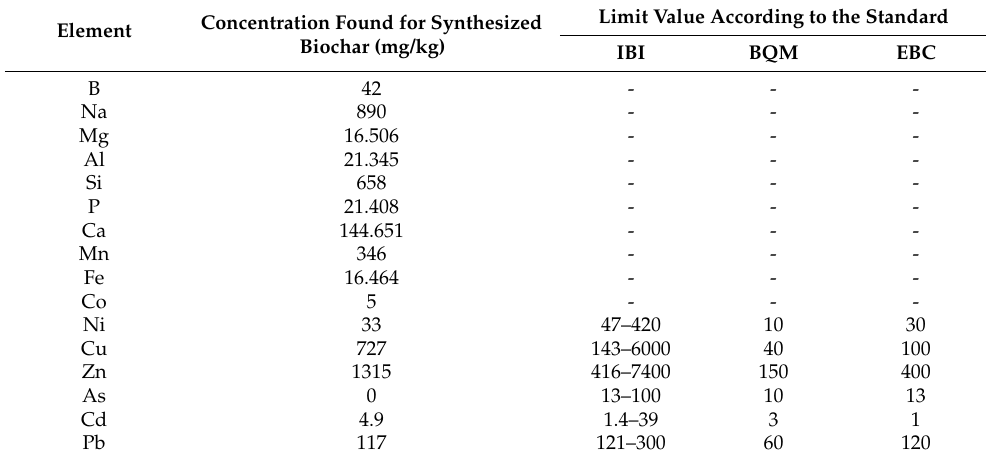
Table 1. Permissible content of contaminants in biochar, based on the existing quality standard (IBI: International Biochar Initiative; BQM: British Biochar Foundation; EBC: European Biochar Foundation. Limit Value According to the Standard Element Concentration Found for Synthesized Biochar (mg/kg) IBI BQM EBC B